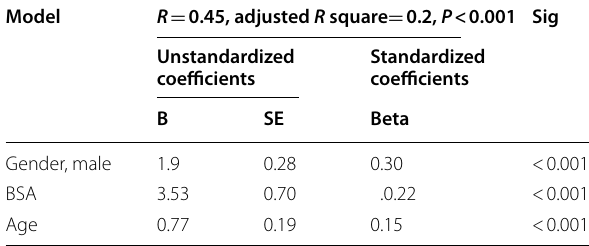
Table 28 Linear regression analysis to predict aortic tubular diameter Model R